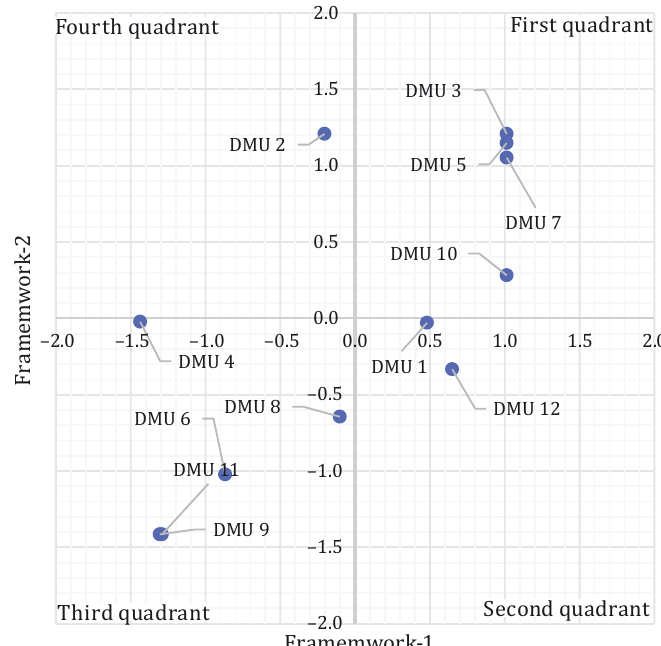
Figure 3. Result of z-value for Framework-1 and